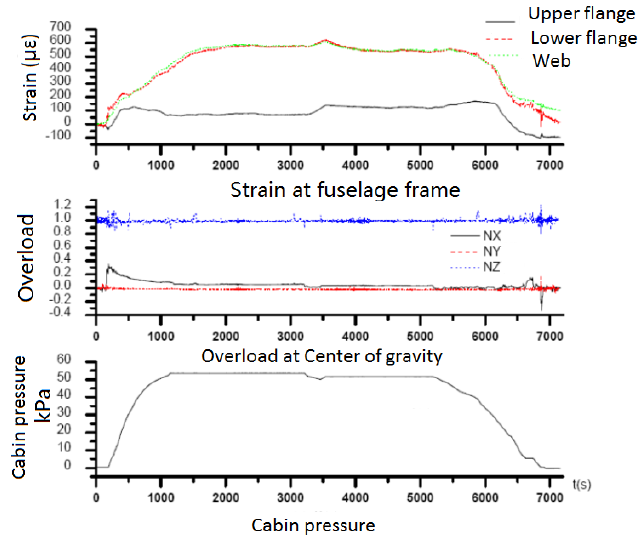
Figure 9. History of local strain and some flight parameters.